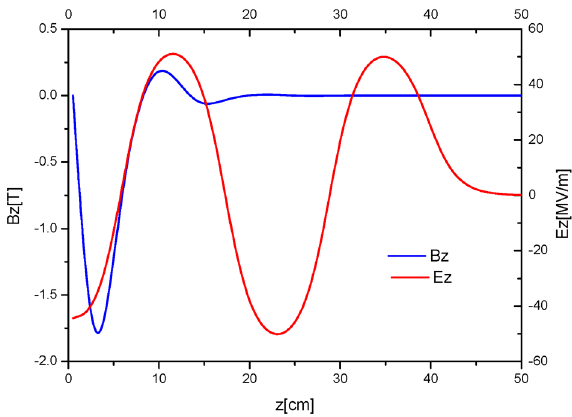
FIG. 3. (Color) Electric and magnetic field strength of the and the TE mode on the axis of the 3 1 TM 010 011